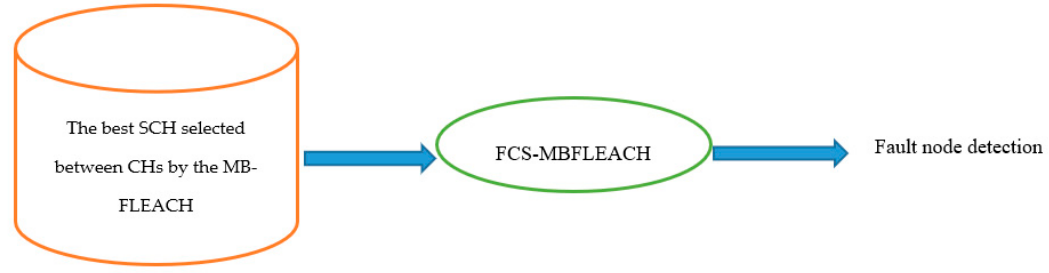
Figure 6. Fault detection system.